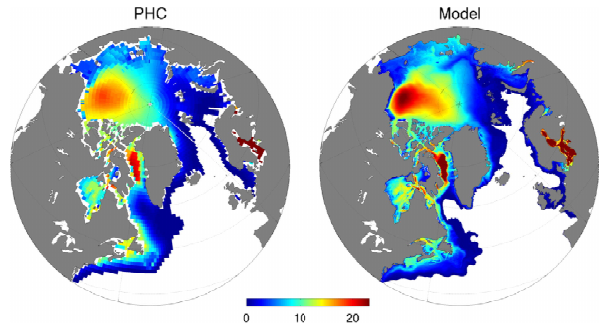
Figure 8. Mean liquid freshwater content (in metres) from the PHC climatology (left) and from hindcast H05 (right) for the period 2003–2009. The white regions of the ocean correspond to regions where salinity at any depth is above the 34.8 reference salinity used to compute the freshwater